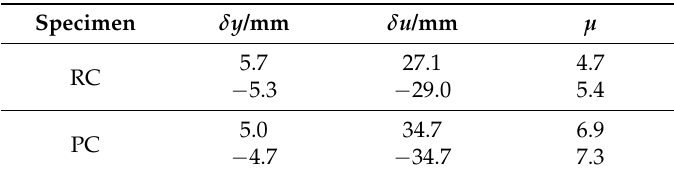
Figure 13. Equivalent viscous damping coefficient curves. Table 3. Displacement ductility coefficient.